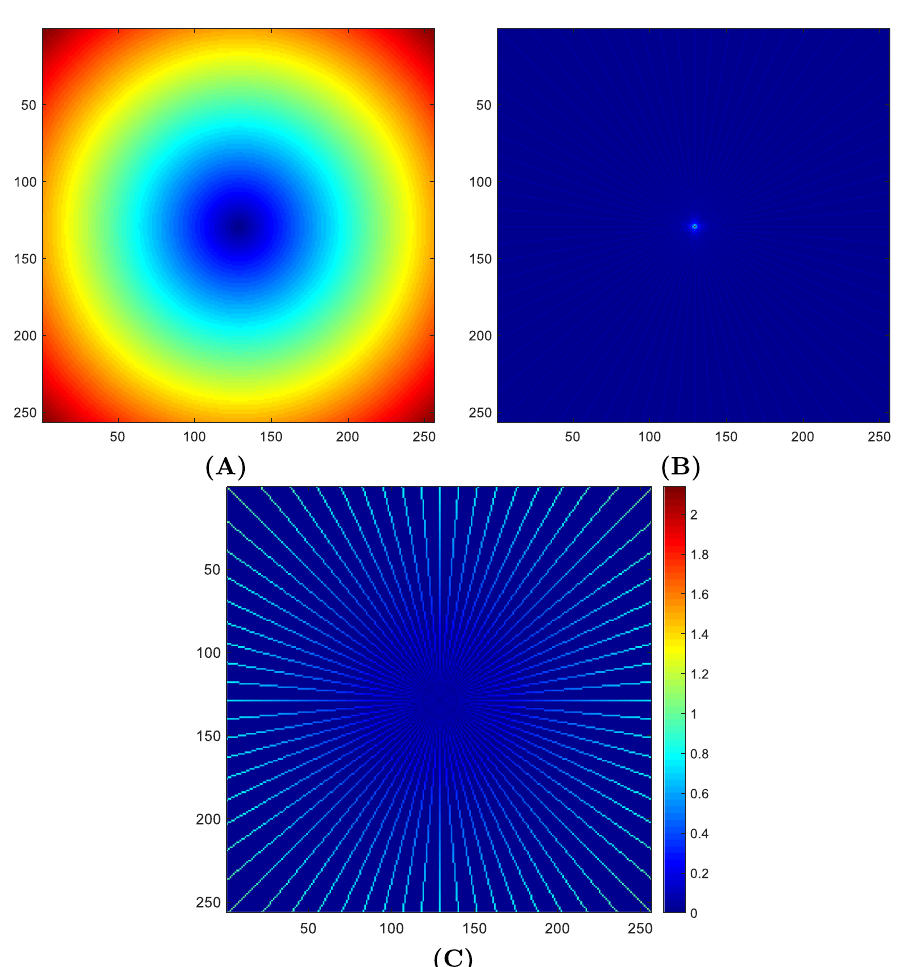
Fig 3. An example of constructing a weighted filter with 36 projections. (A) common ramp filter; (B) projection trajectories; (C) weighted ramp filter. To emphasize the visual effect of weight, the elements not on the projection trajectories are set to